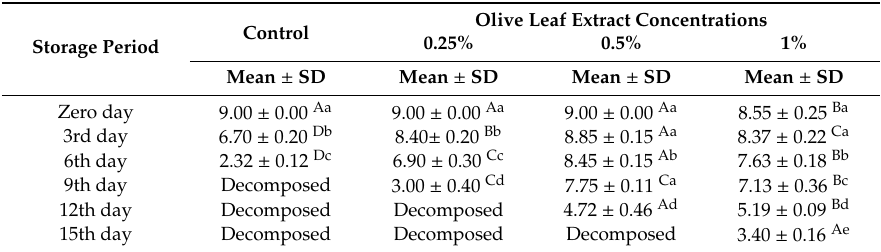
Table 1. Pattern of the overall acceptance of the fresh poultry meat treated with di ff erent concentrations of olive leaf extract during the chilling storage period at 4 ± 1 ◦ C (mean ± standard deviation